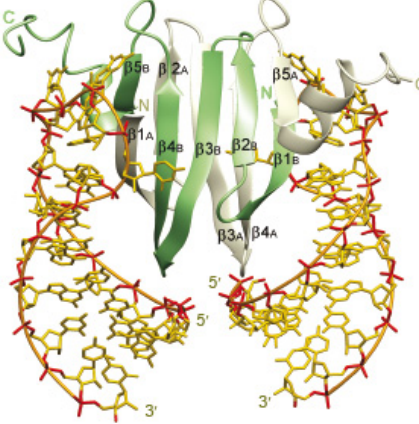
Figure 2. Structure of the RsmE-RNA complex of P. fluorescens . Solution structure of the 2:2 complex of RsmE with 20-nucleotide hcnA sequence. Protein ribbons belonging to each monomer are shown in green and grey. Heavy atoms of the two RNAs are shown in yellow (carbon and nitrogen) and red (oxygen and phosphorus). The linking phosphates are shown in orange. From